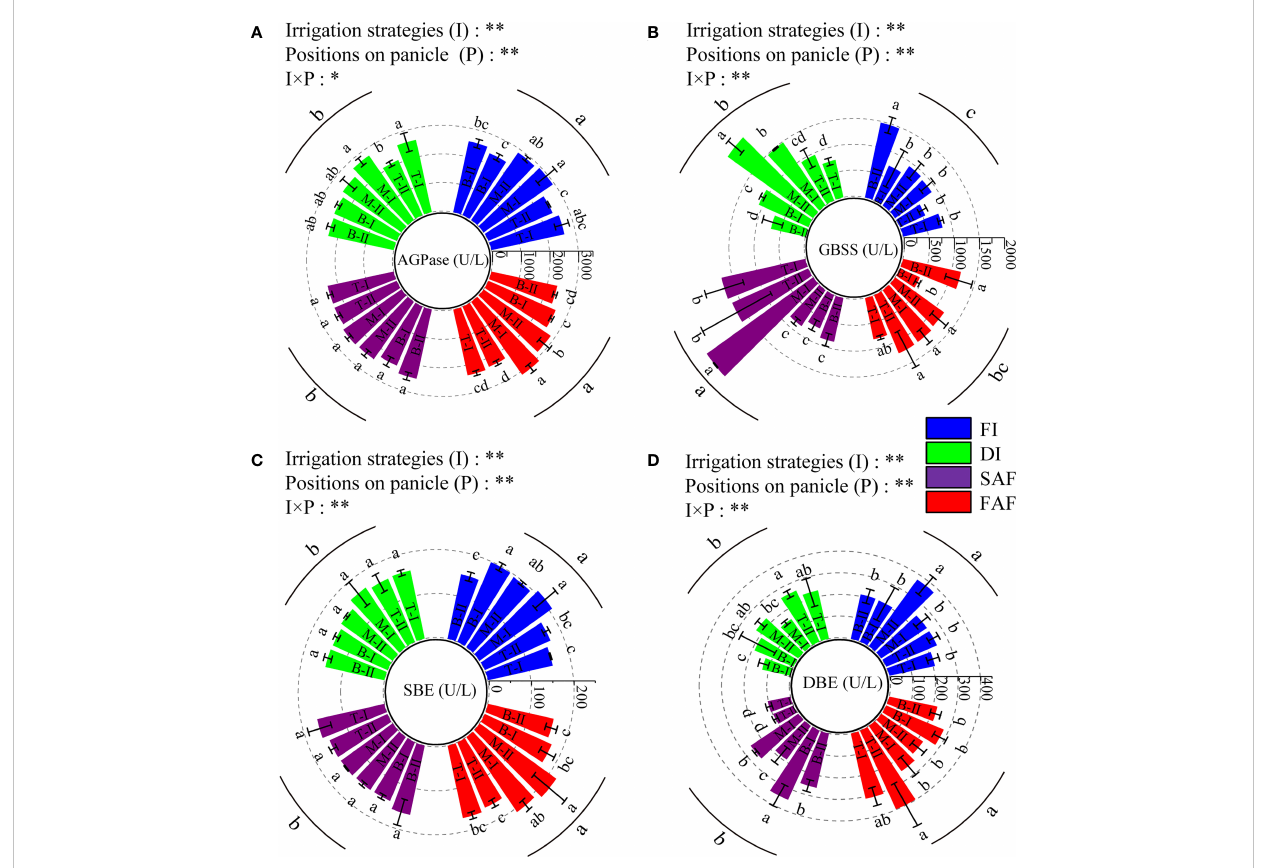
FIGURE 5 ADP-glucose pyrophosphorylase activity (A) , granular starch synthase activity (B) , starch debranching enzyme activity (C) and starch branching enzyme activity (D) in grains on different positions of panicles at the middle grain fi lling stage. The catalytic production of 1 m mol NADPH per minute by 1L reaction system is de fi ned as one enzyme unit (U/L). The vertical line on the column represents three repeated standard errors. Different letters represent signi fi cant difference among treatments (P< 0.05). The Least-Signi fi cant Difference Test (LSD) was used for comparison. ANOVA of treatment (T) and positions of panicle (P) and their interaction (T × P) (**P< 0.01; *P< 0.05). FI, the whole growing season fl ooding; DI, the whole growing season normal drip irrigation (soil relative moisture (RSM) was maintained in a range of 90 – 100%); SAF, pre-anthesis normal drip irrigation and post-anthesis water stress (the RSM was maintained in a range of 80 – 90% after anthesis); FAF, pre-anthesis normal drip irrigation and post- anthesis fl ooding; T, M and B represent the top, middle and bottom of the panicles respectively, and the Roman numerals I and II represent the primary and secondary branches